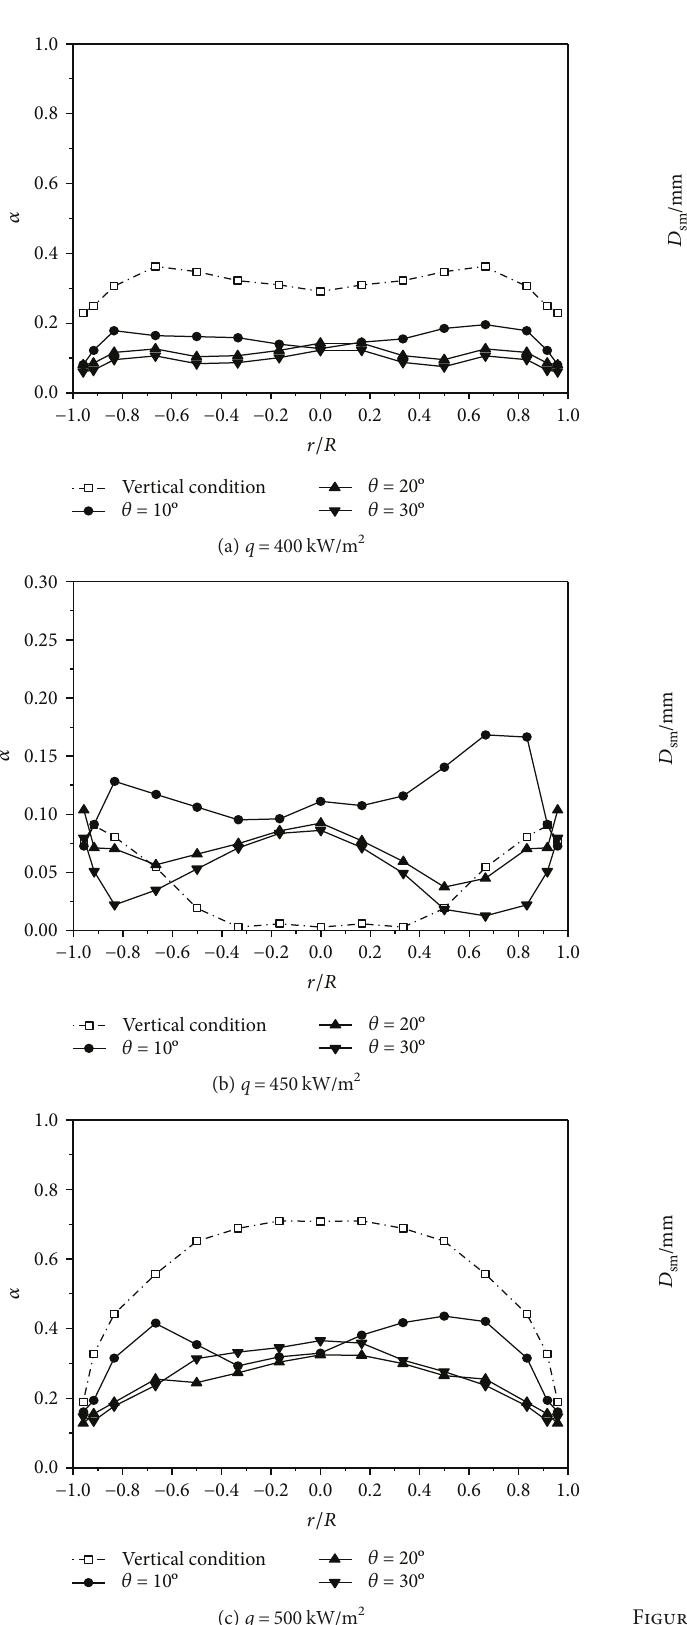
Figure 9: Inclination angle e ff ect on the local void fraction on the direction of β = 0 ∘ in cross section ( P = 0 5 MPa, G = 500 kg/m 2 s).